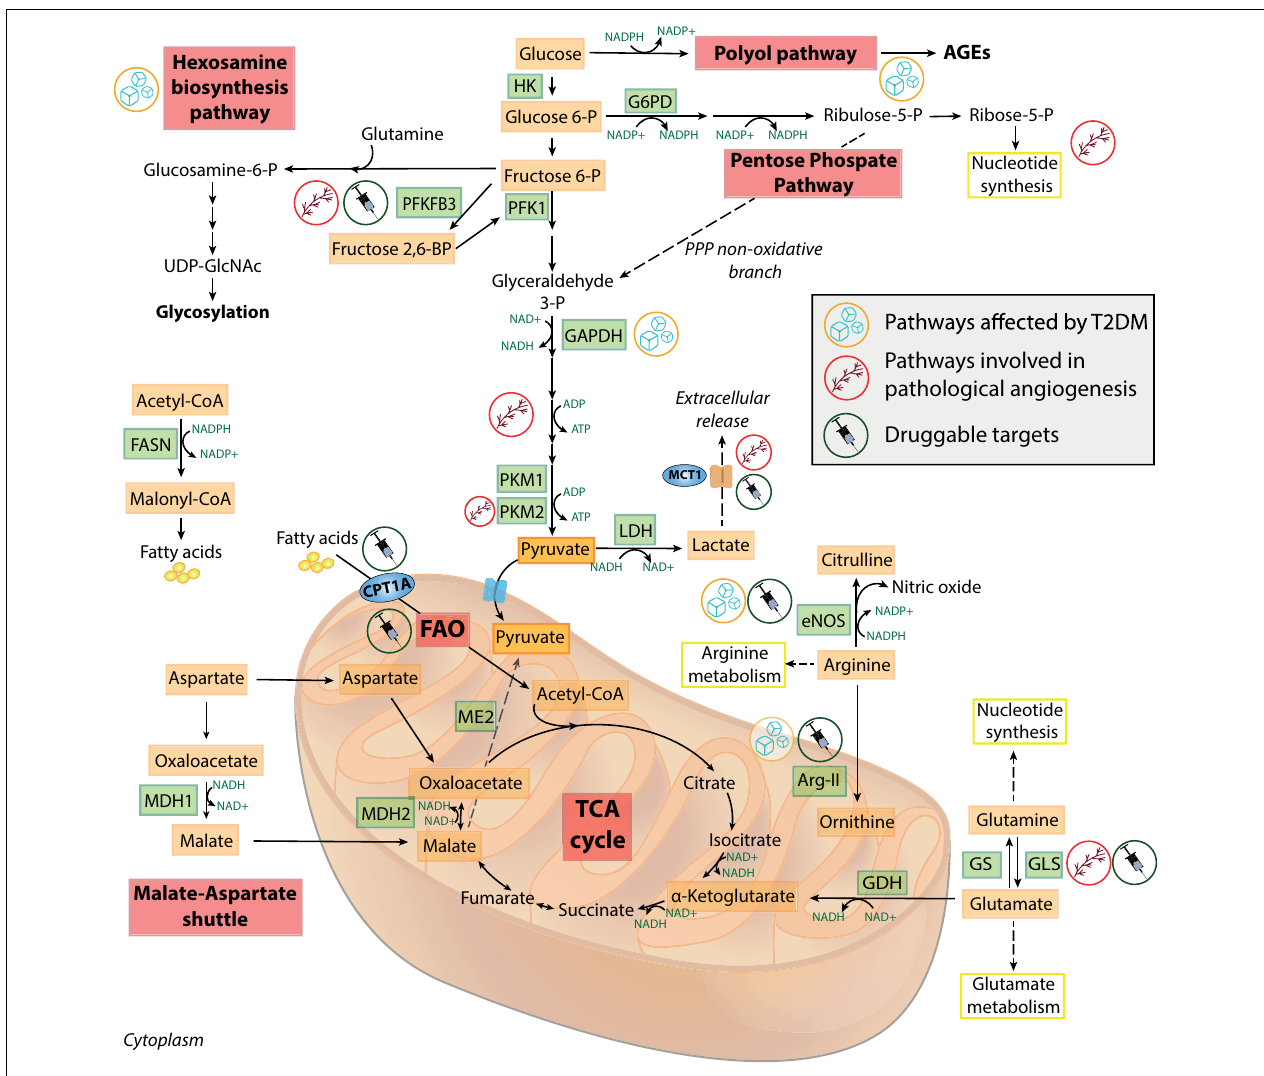
FIGURE 2 | Metabolic features of healthy and dysfunctional endothelial cells. Schematic overview of the most relevant metabolic pathways in endothelial cells. Pathways, enzymes and metabolites affected by T2DM or involved in pathological angiogenesis, and the druggable targets discussed in the text, are labeled by specific icons. AGEs, advanced glycation end-products; Arg-II, arginase II; CPT1A, carnitine palmitoyltransferase 1A; eNOS, endothelial nitric oxide synthase; FAO, fatty acid oxidation; FASN, fatty acid synthase; G6PD, glucose 6-phosphate dehydrogenase; GAPDH, glyceraldehyde 3-phosphate dehydrogenase; GDH, glutamate dehydrogenase; GLS, glutaminase; GS, glutamine synthetase; HK, hexokinase; LDH, lactate dehydrogenase; MCT1, monocarboxylate transporter 1; MDH1/MDH2, malate dehydrogenase 1/2; ME2, malic enzyme 2; PFK1, phosphofructokinase 1; PFKFB3, 6-phosphofructo-2-kinase/fructose-2,6-biphosphatase 3; PKM1/PKM2, pyruvate kinase 1/2; PPP, pentose phosphate pathway; T2DM, type 2 diabetes; TCA, tricarboxylic acid; UDP-GlcNAc, uridine diphosphate